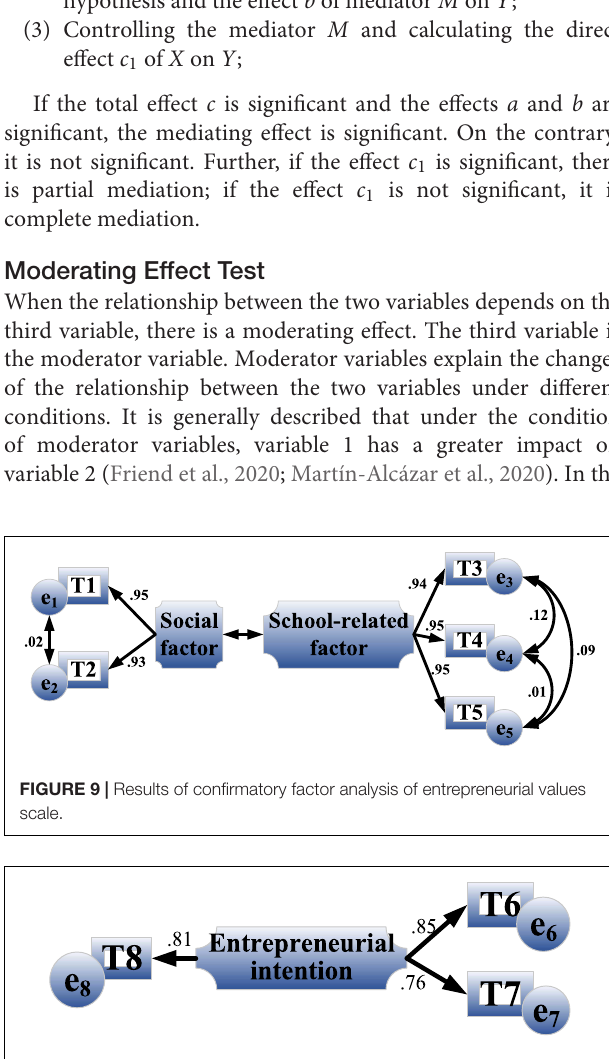
FIGURE 10 | Confirmatory factor analysis results of entrepreneurial